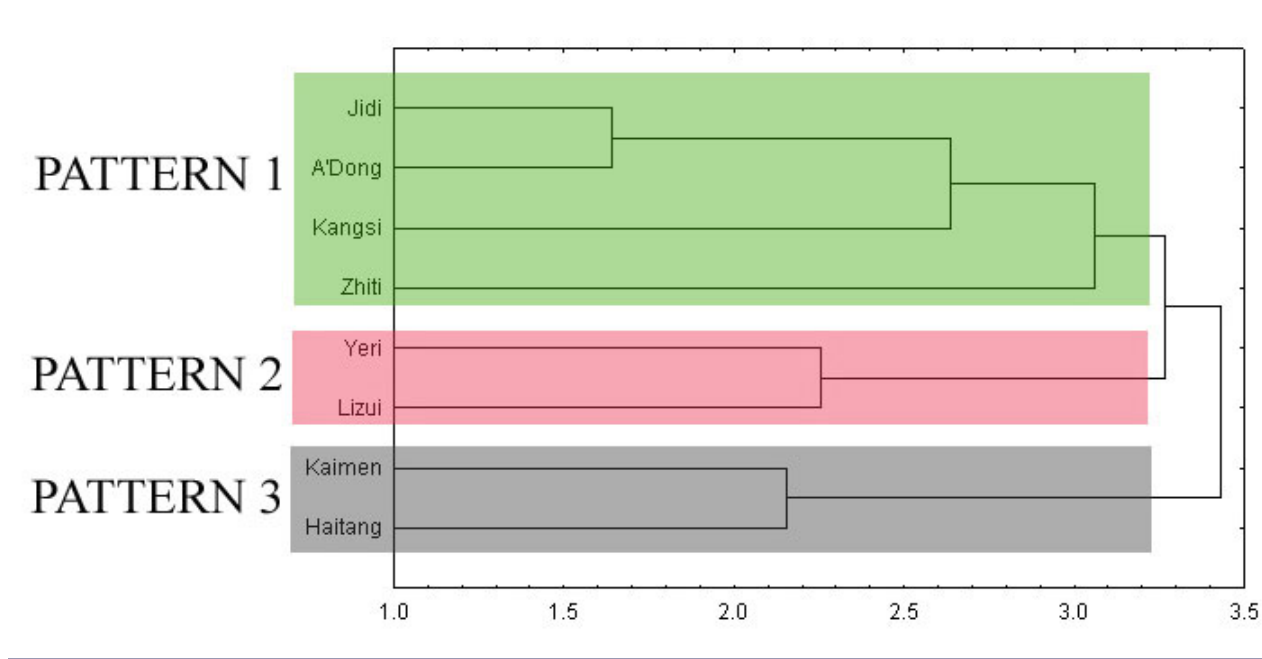
Fig. 3. Diagram showing the clustering of eight